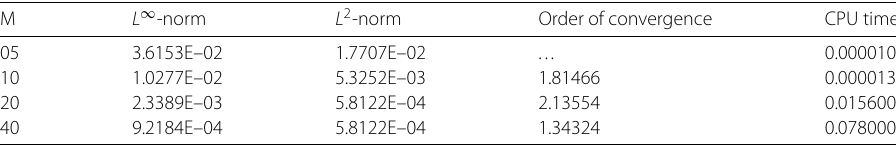
at T = 0.5 for Problem M